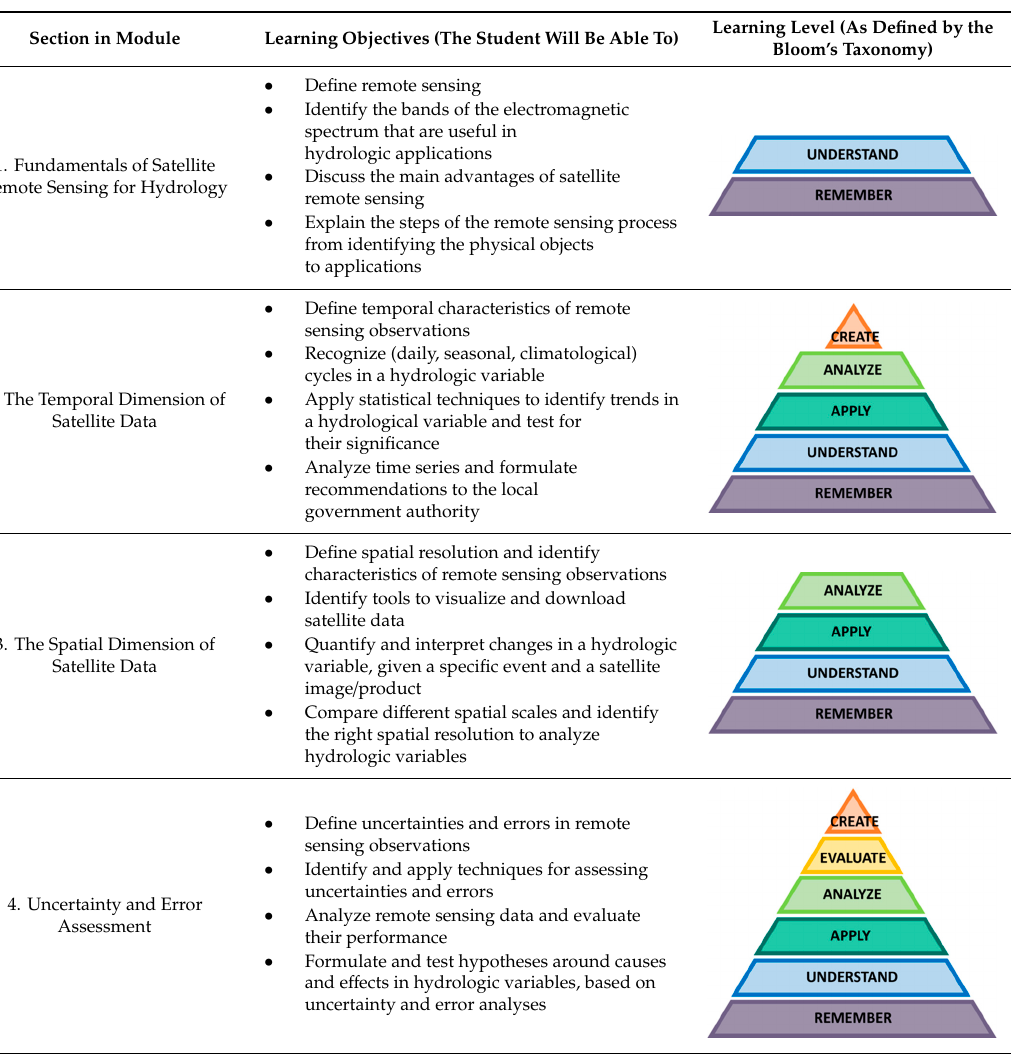
Table 1. Learning objectives of the HydroLearn Remote Sensing Applications in Hydrology module and corresponding Bloom’s Taxonomy.